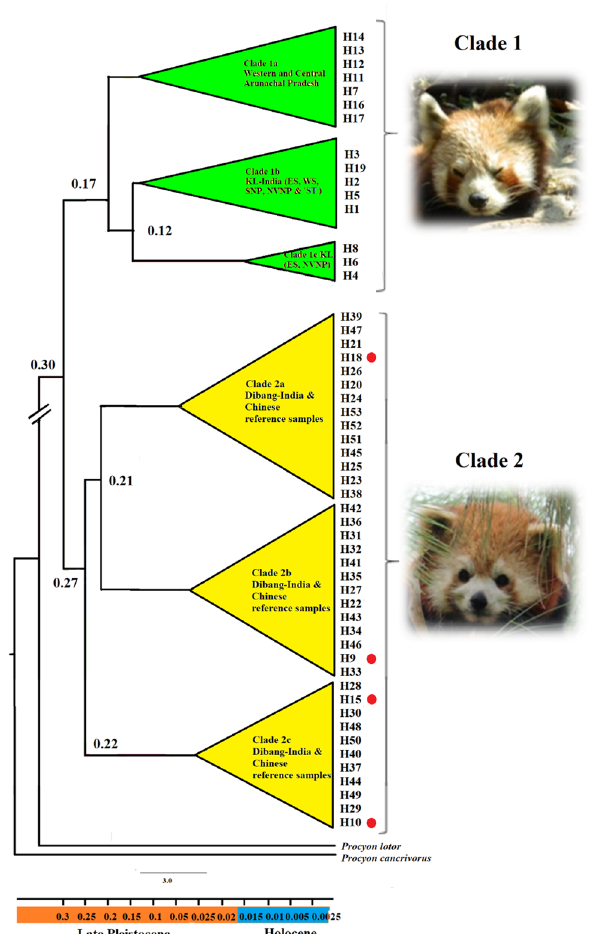
Figure 2. Re-construction of Bayesian based phylogenetic relationship using mitochondrial control region ( Mentioned values on the nodes indicated the divergence time estimated in million years ago (median divergence estimate). Clade 1a represented western and central Arunachal, 1b represented KL-India and Tibet, and 1c represented clade KL-India, clade 2a, 2b, 2c represented the haplotypes from Dibang valley (H9, H10, H15, H18 marked with red circles) and haplotypes of the sequences of Chinese red panda retrieved from NCBI